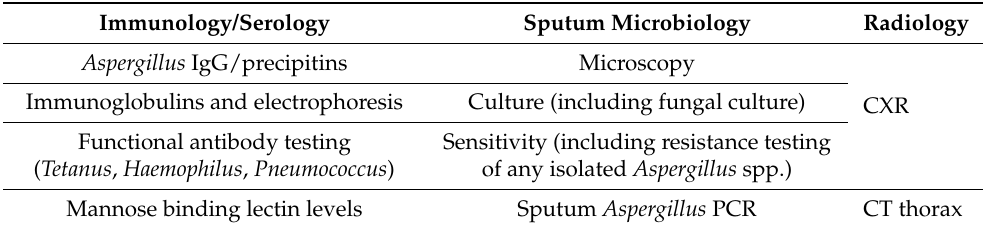
Table 2. Mandatory diagnostic tests for patients suspected of having